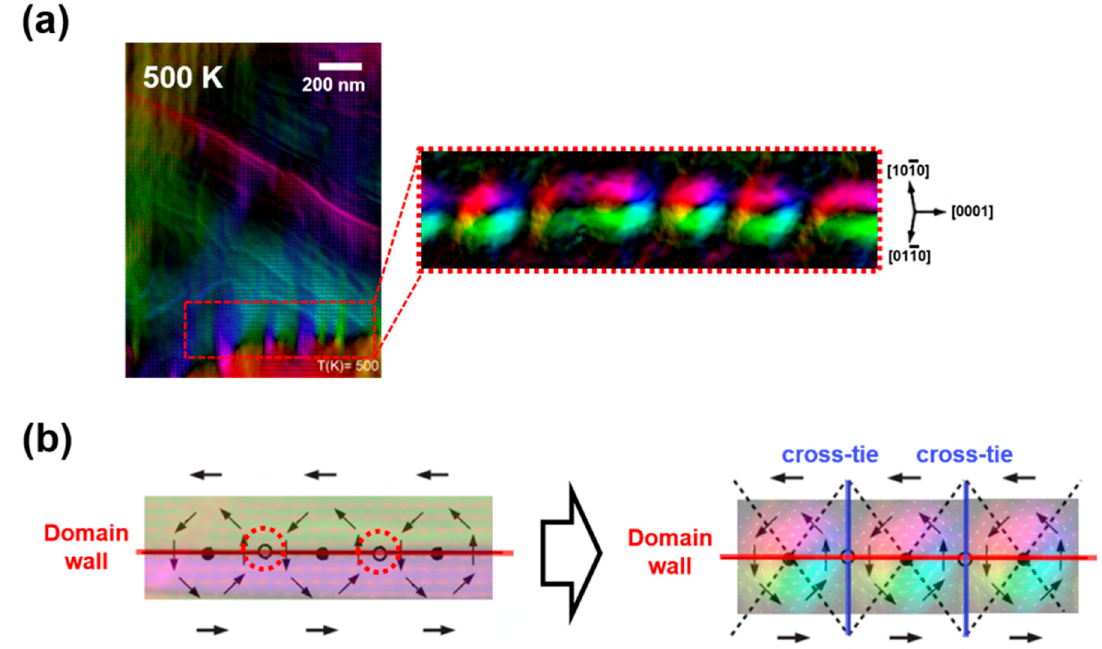
Figure 4. Sequential images of the magnetic vector maps of the Z-type hexagonal ferrite by heating from 350 to 500 K. The color wheel represents the magnetization direction at every point.